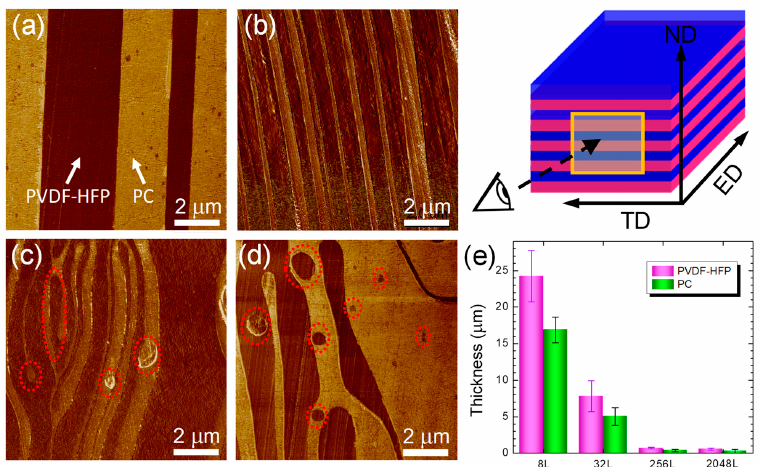
Figure 3. AFM phase images for PVDF-HFP / PC films: ( a ) 32 L, ( b ) 256 L, ( c ) 2048 L and ( d ) 16384 L. ( e ) is the statistical layer thicknesses determined by AFM analysis. Regions inside the dashed circles in (c) and (d) indicate the broken layers. The scheme appended in the upper right corner shows the configuration of observed cross-sections relative to the extrusion direction (ED), transverse direction (TD), and normal direction (ND) of the